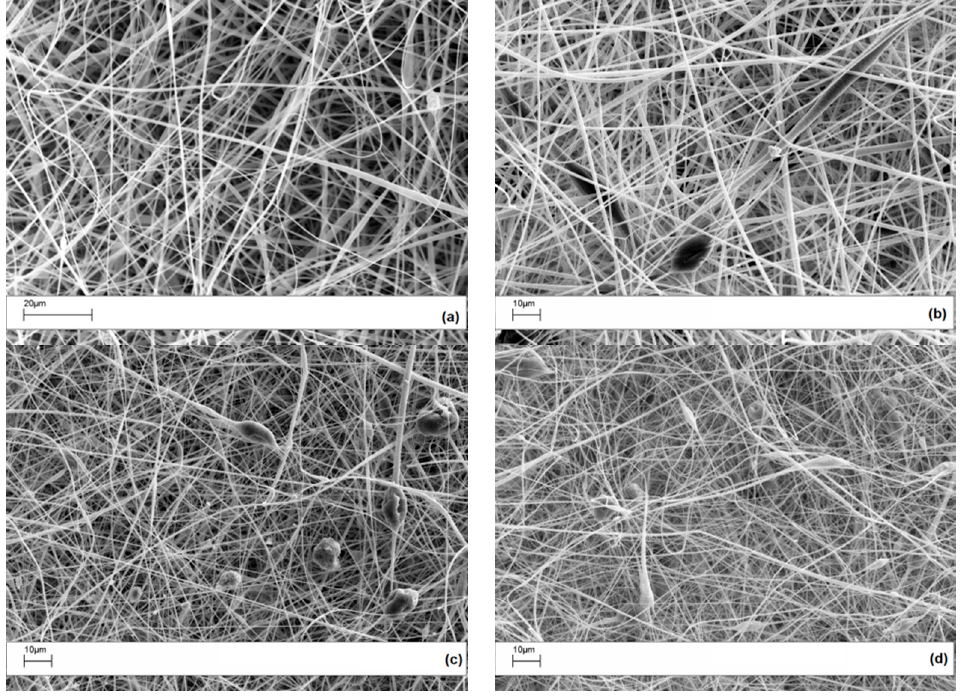
Figure 2. SEM images of electrospun PES veils: ( a ) coPES; ( b ) coPES/1%POSS; ( c ) coPES/5%POSS; and ( d ) coPES/10%POSS.